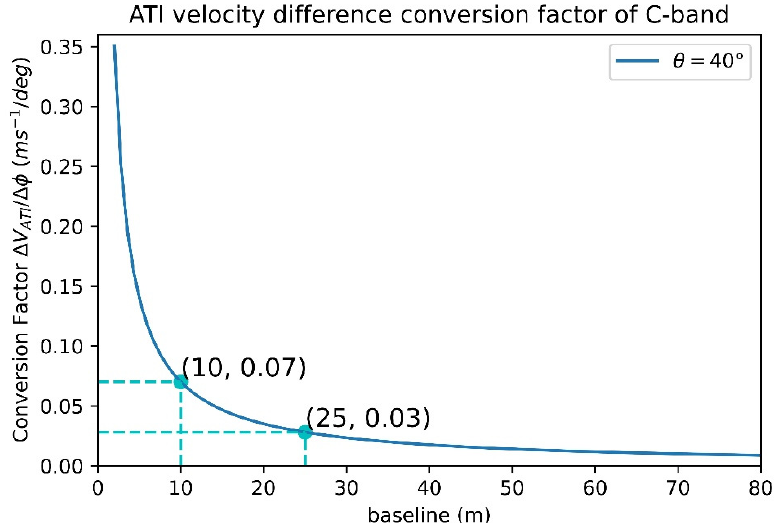
Figure 6. The relationship between the accuracy of the retrieved velocity as indicated by the ratio between velocity difference and phase difference, ∆ v ATI / ∆ φ , and radar baseline.